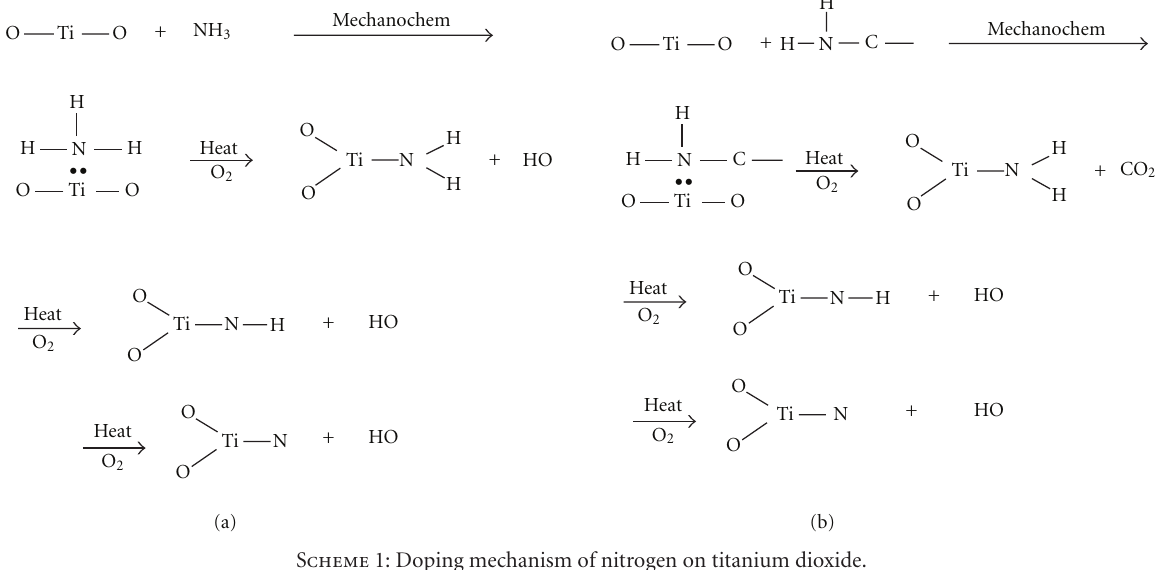
Scheme 1: Doping mechanism of nitrogen on titanium dioxide.